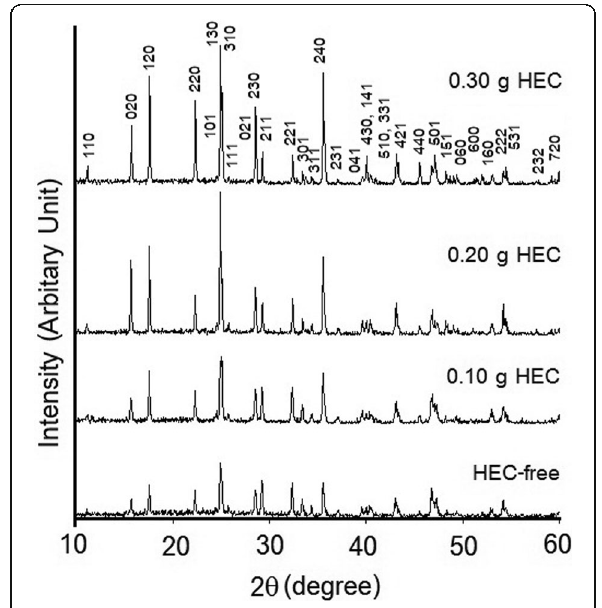
Fig. 1 XRD spectra of Sb 2 S 3 synthesized in the solution containing 0, 0.10, 0.20, and 0.30 g HEC